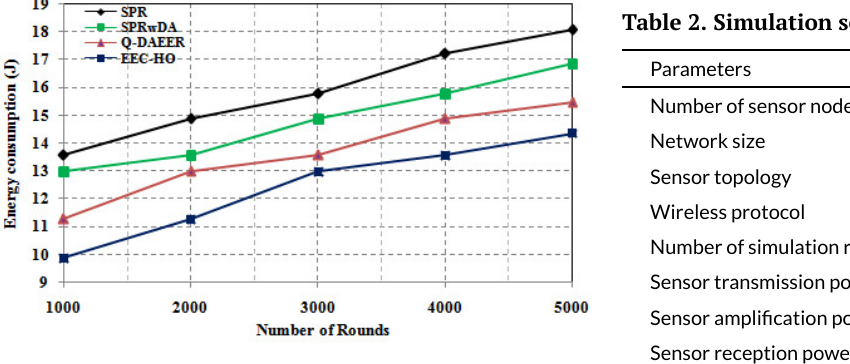
Figure 7. Energy consumption with number of simulation rounds